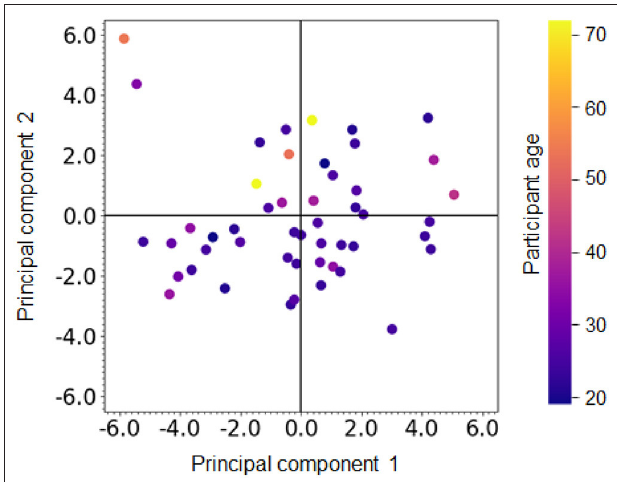
FIGURE 10 | Individual data for PCA components 1 and 2. Different colors indicate different participant